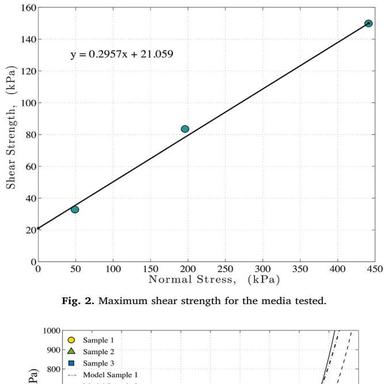
Unconfined compression for three samples at Diablo Regimiento mine .